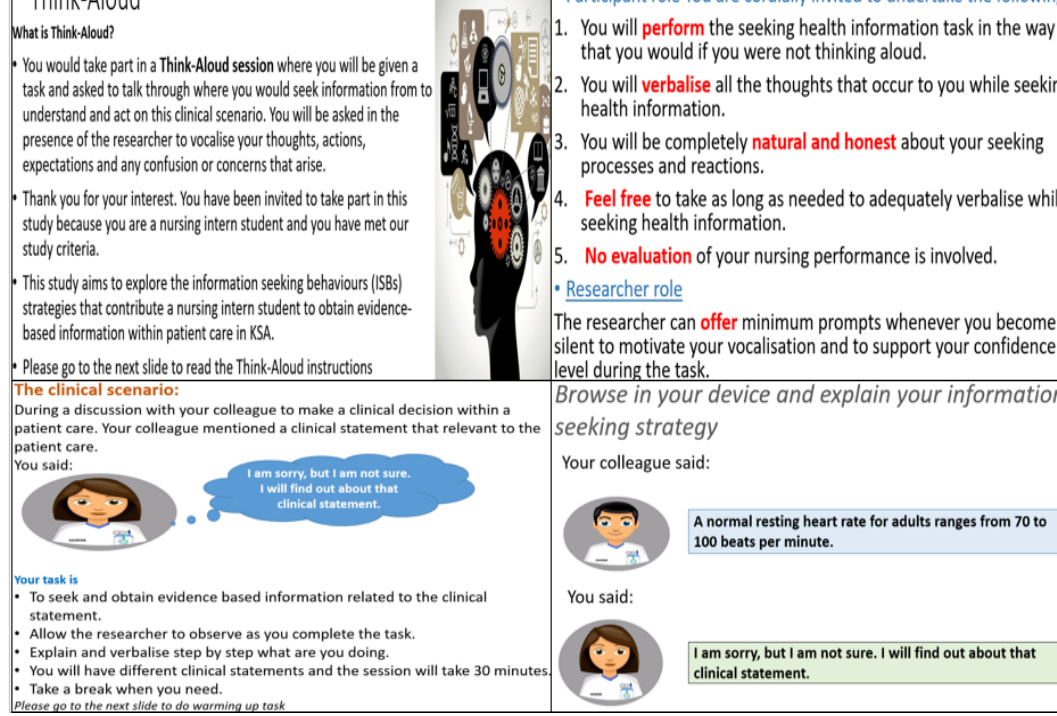
Figure 1. TA instructions.